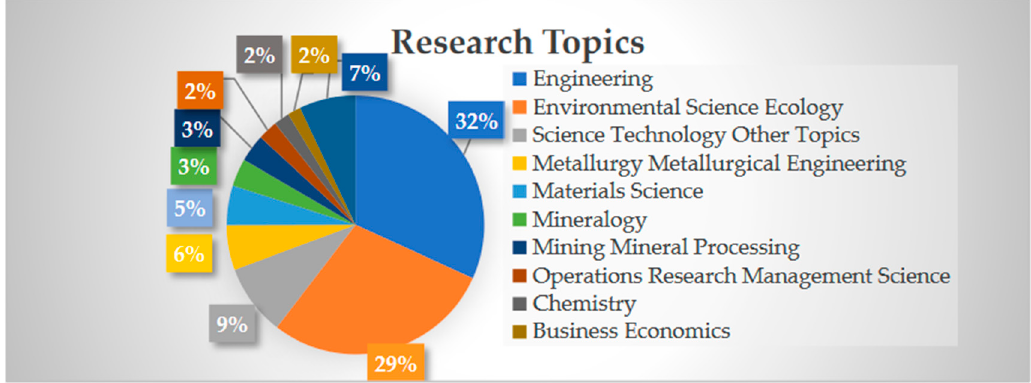
Figure 9. Subject categories.